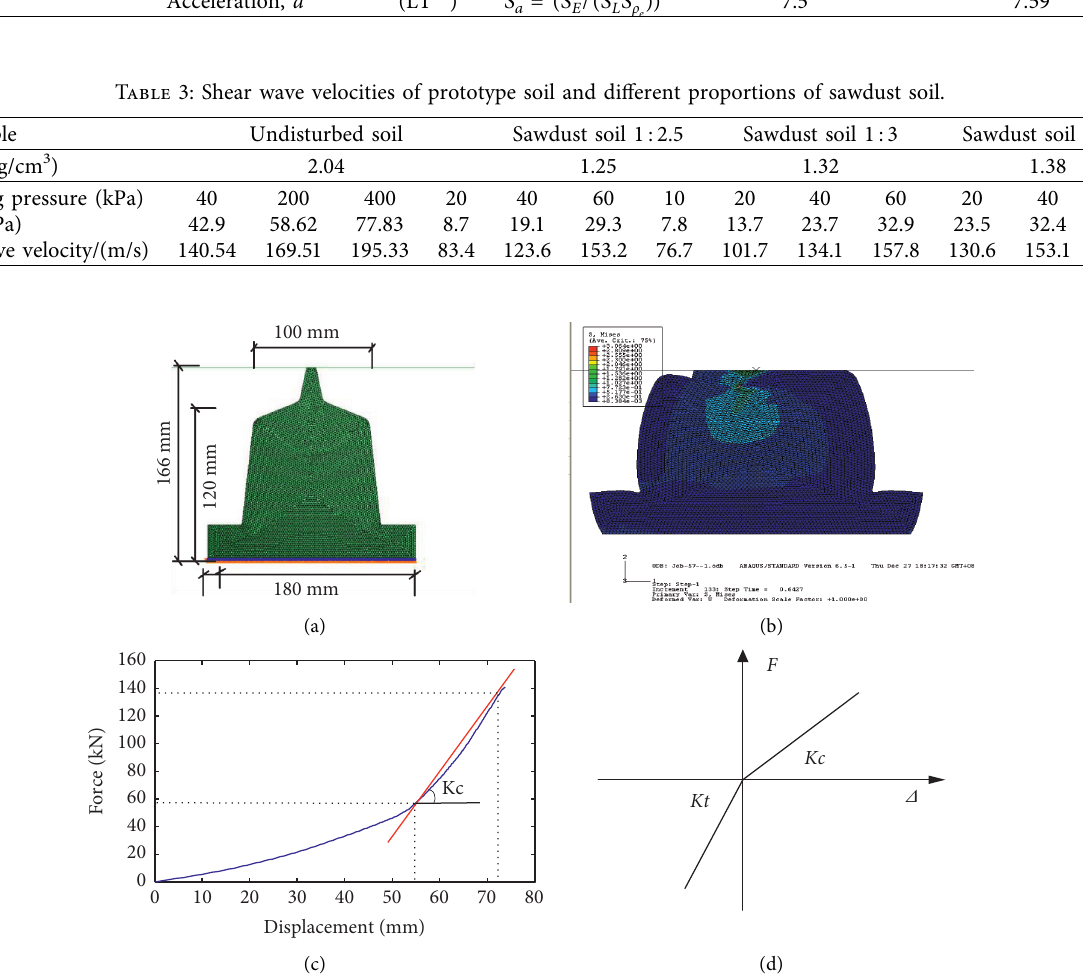
Figure 4: The simplified joint model. (a) Finite element model of Gina gasket. (b) Compression deformation. (c) Force-displacement cures. (d) Simplified mechanical